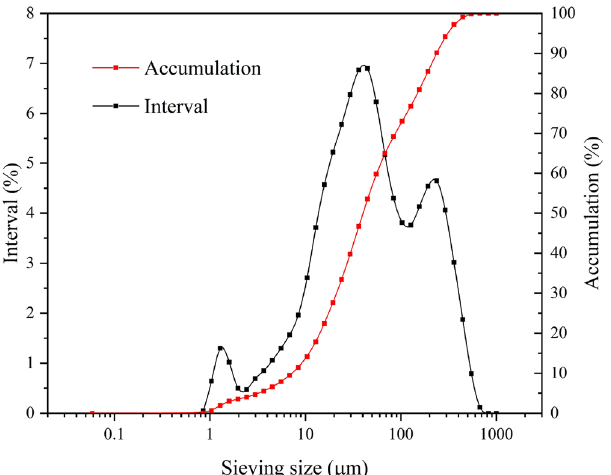
Figure 1. Cement particle size distribution curves.